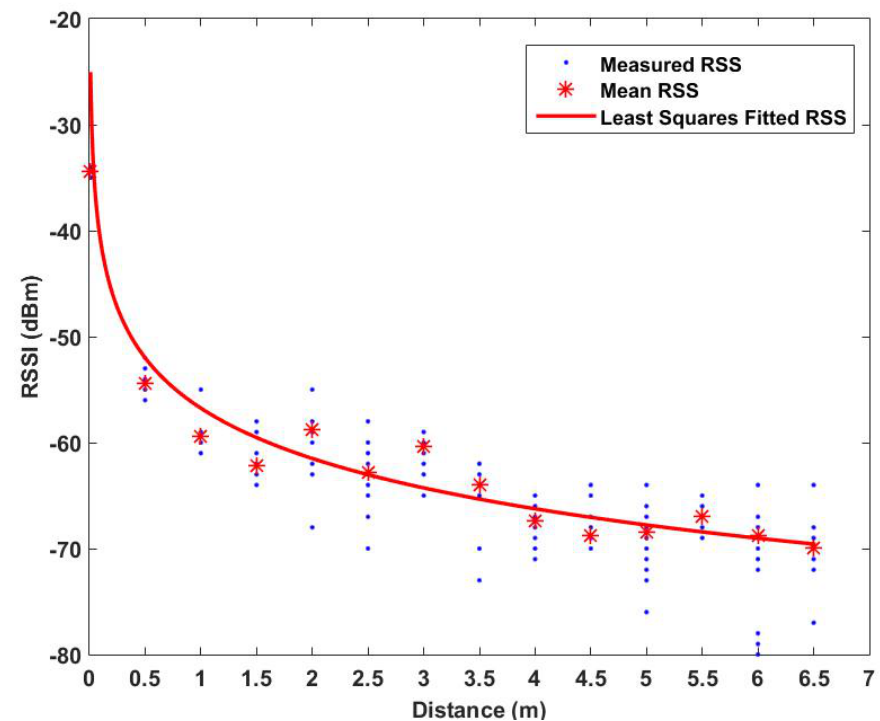
Figure 4. Relationship between RSS of a BLE beacon and